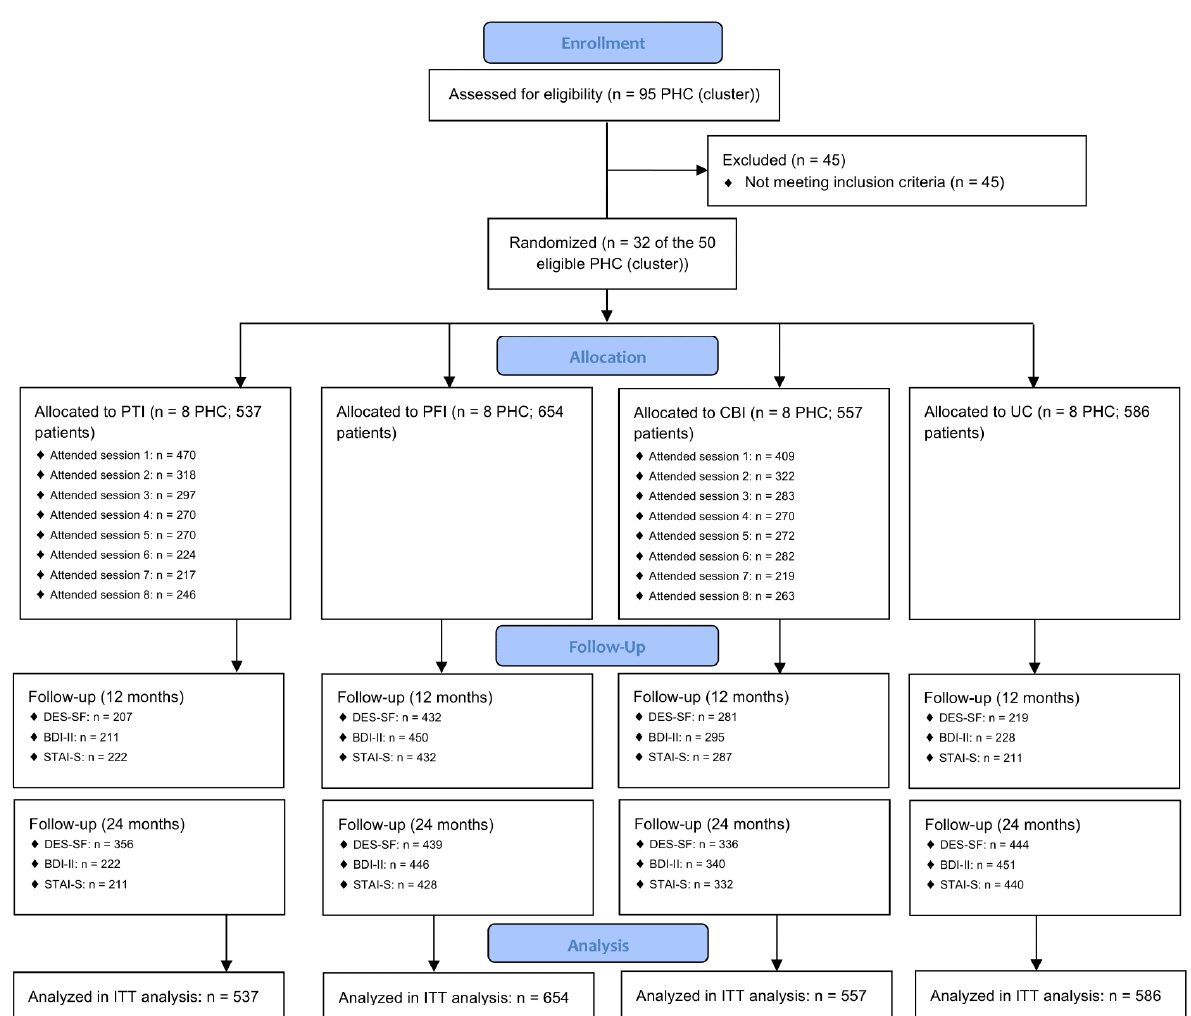
Figure 1. Flowchart illustrating the progress of participants throughout the trial. BDI-II: Beck Depression Inventory-II; DES-SF: Diabetes Empowerment Scale-Short Form; ITT: intention-to-treat; STAI-S: State subscale of the Trait Anxiety Inventory; PHC: Primary Healthcare Center; UC: usual care.